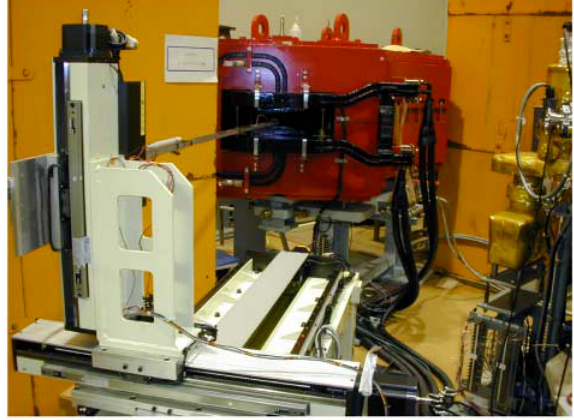
FIG. 10. (Color) Three-axes stage and model magnet aligned.